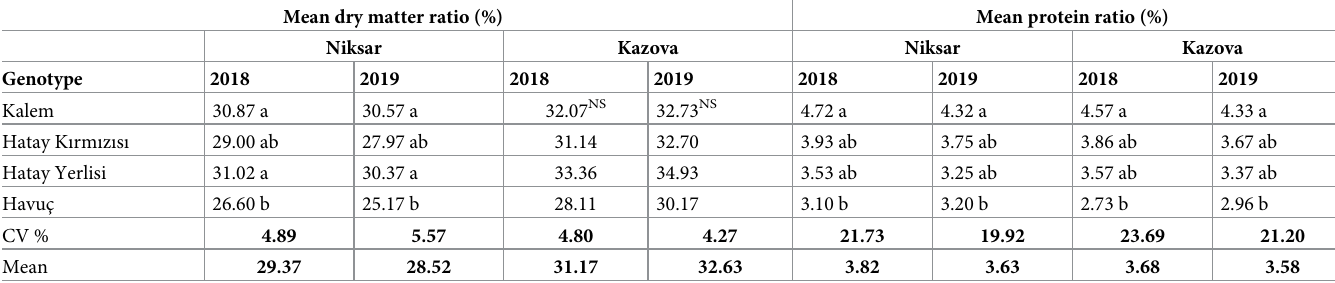
Table 5. Dry matter and protein ratio of different local sweet potato genotypes used in the current